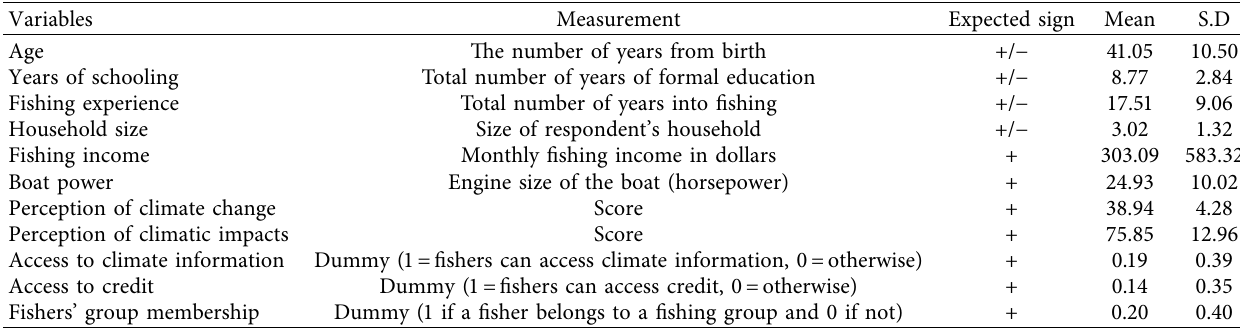
Table 3: Description of the